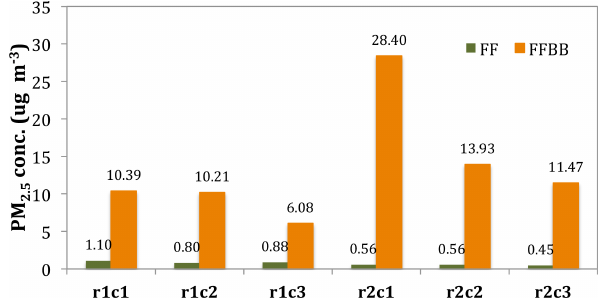
Figure 7. The mean PM 2 . 5 concentration (µgm − 3 ) in FF and FFBB for selected cases in the Sumatra region (r1) and the Borneo region